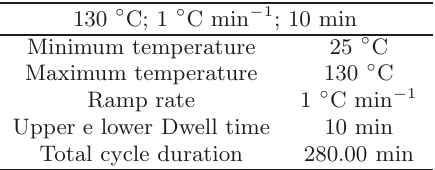
Table 3. Testing profile 2 (130 ◦ C, 1 ◦ C min − 1 , 10 min).